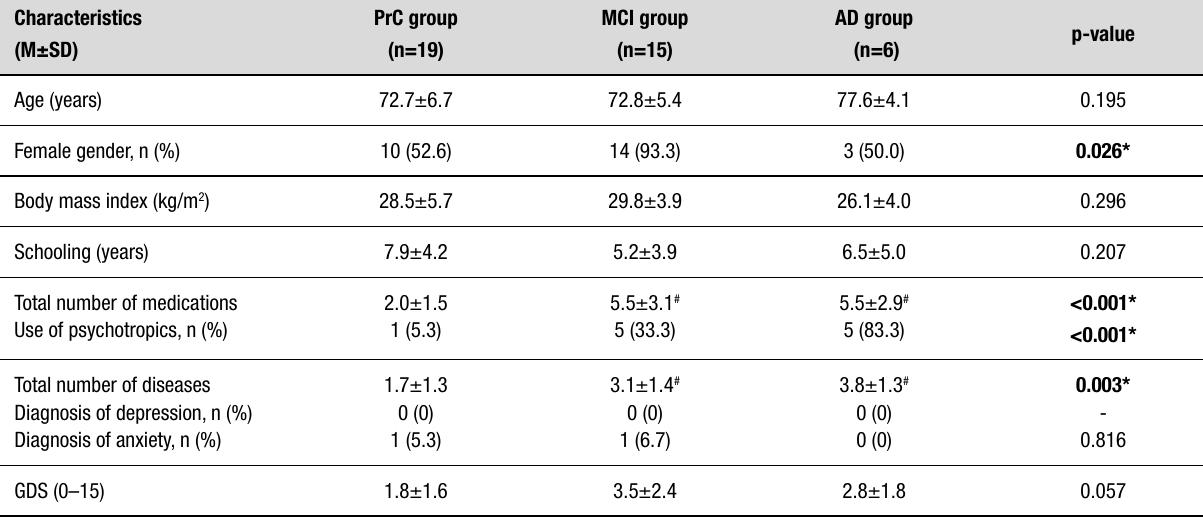
Table 1. Descriptive characteristics of the sample.